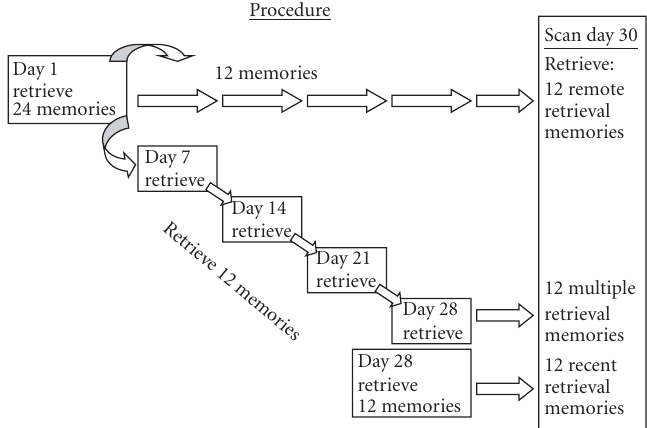
Figure 1: Procedure: On Day 1 of the one month study, 24 autobiographical memories were retrieved; 12 of those were not retrieved again until the day of the scan (remote retrieval condition), and 12 were retrieved on four successive sessions throughout the month (multiple retrieval condition). Additional 12 autobiographical memories were retrieved for the first time on Day 28 of the study (recent retrieval condition). All 36 memories were then retrieved in the scanner on Day